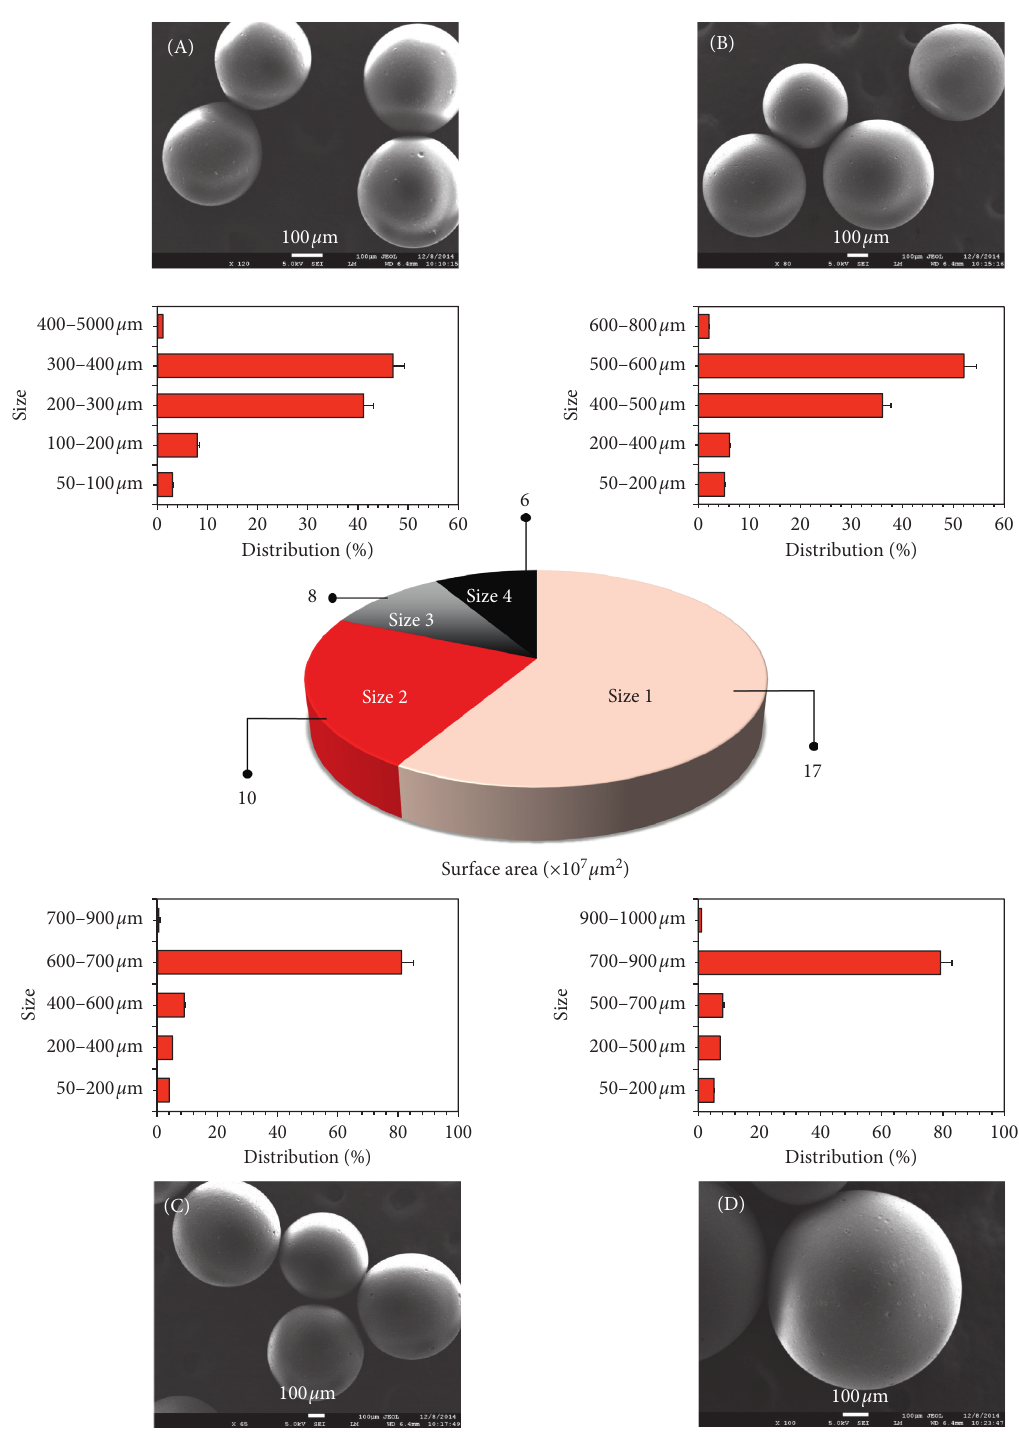
Figure 1: SEM images of the spheres from different size categories along with their size distributions: (a) MMS-1 (200–400 μ m); (b) MMS-2 (400–600 μ m); (c) MMS-3 (600–700 μ m); (d) MMS-4 (700–900 μ m). Specific surface area measurement for 10mg of each size group is presented in the